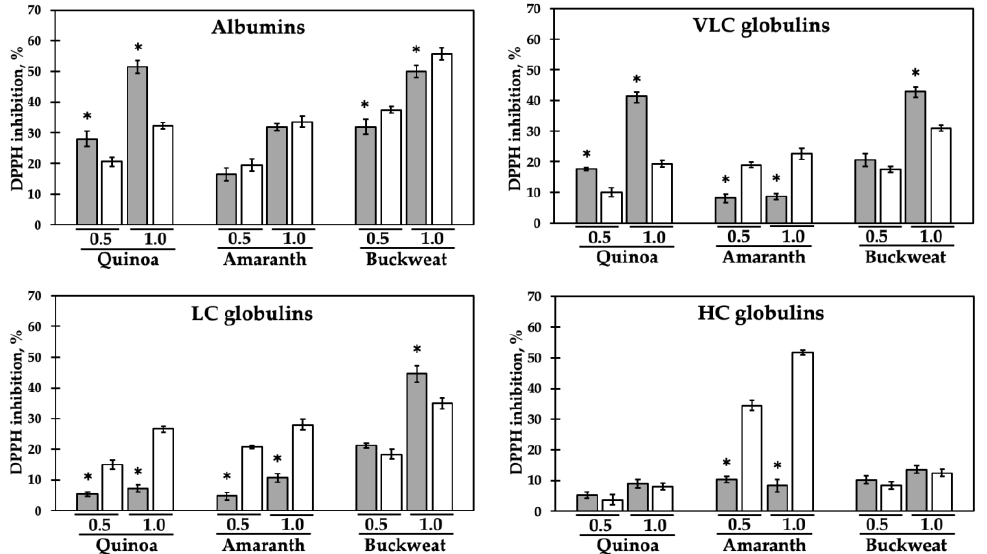
Figure 5. DPPH (2,2-diphenyl-1-picrylhydrazyl) radical inhibition percentage at two different protein concentrations (0.5 mg/mL and 1.0 mg/mL) of each separated protein class, in the native form (gray bars) and after simulated gastro-intestinal digestion (white bars). * p < 0.05 vs. digested form. Each experiment was performed in triplicate.